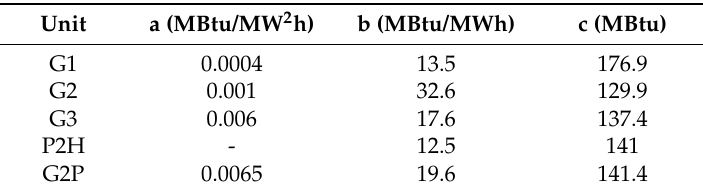
Figure 6. Example six-bus power system. EV: Electric Vehicle. Table 1. Generation unit characteristics 1.